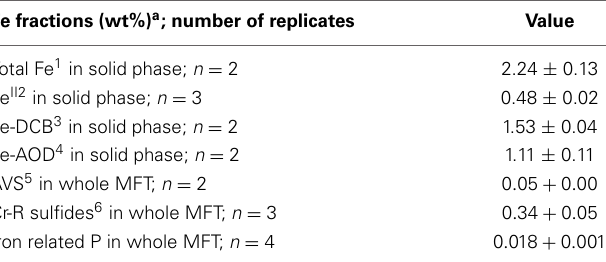
Table 1 | Fractionation of iron (Fe) in MFT prior to amendment and